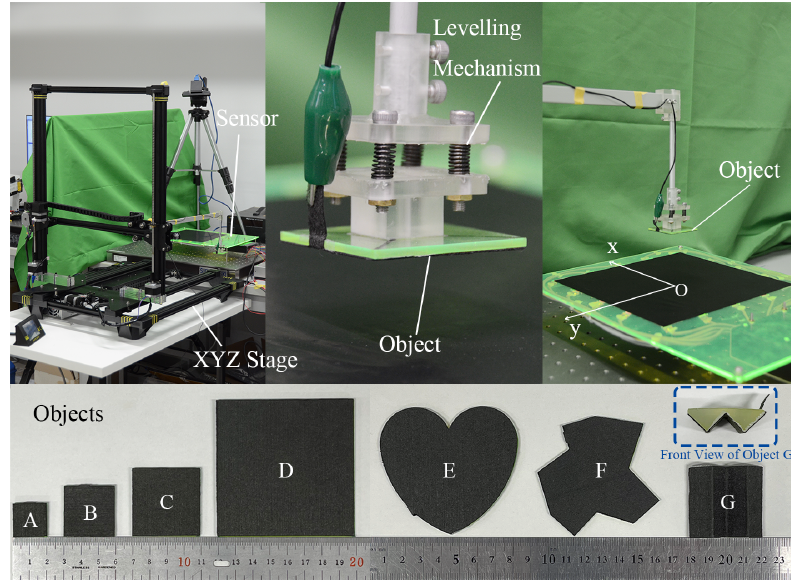
Figure 7. Experiment setup for performance